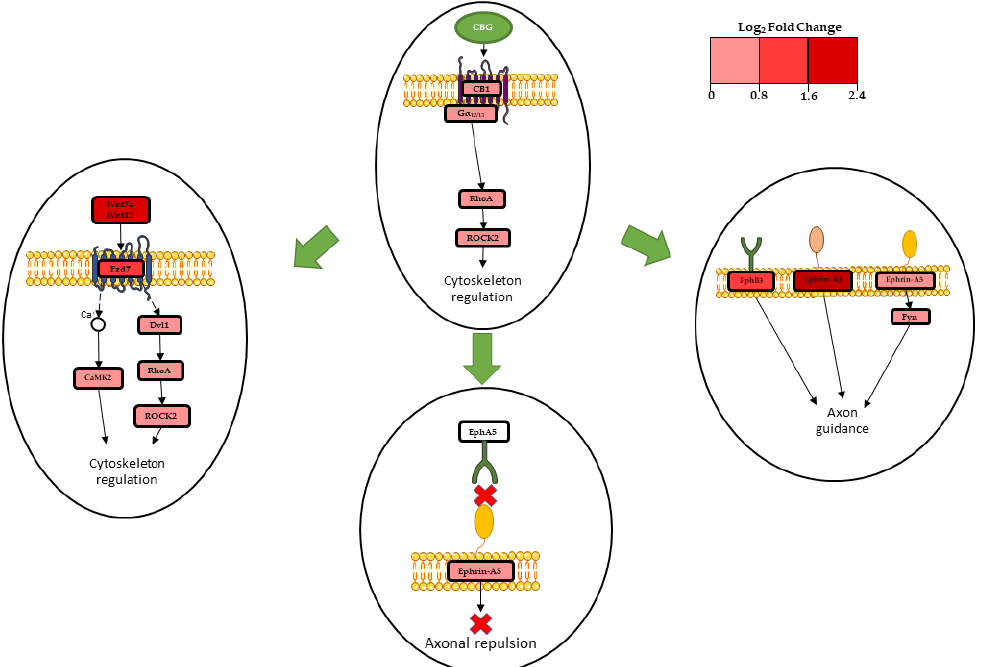
Figure 4. Mechanisms involved in the cytoskeletal remodeling of NSC-34 after CBG treatment. The figure represents pathways involved in the process. A signal influenced by CBG is represented in each oval. Green arrows indicate influence of CB1 activation. Continuous arrows indicate direct associations, while dashed arrows indicate indirect association. A red X indicates that there is no interaction between the receptor and ligand. A red palette indicates genes log 2 Fold Change. The results of transcriptomic analysis suggest that CBG induces initial cytoskeletal remodeling of NSC-34 by WNT/planar cell polarity (PCP) signaling, Ephrin-Eph signaling, and the involvement of CB1. Celsr1 , Celsr2, and Celsr3 codifying for the Cadherin EGF LAG seven-pass G-type re-